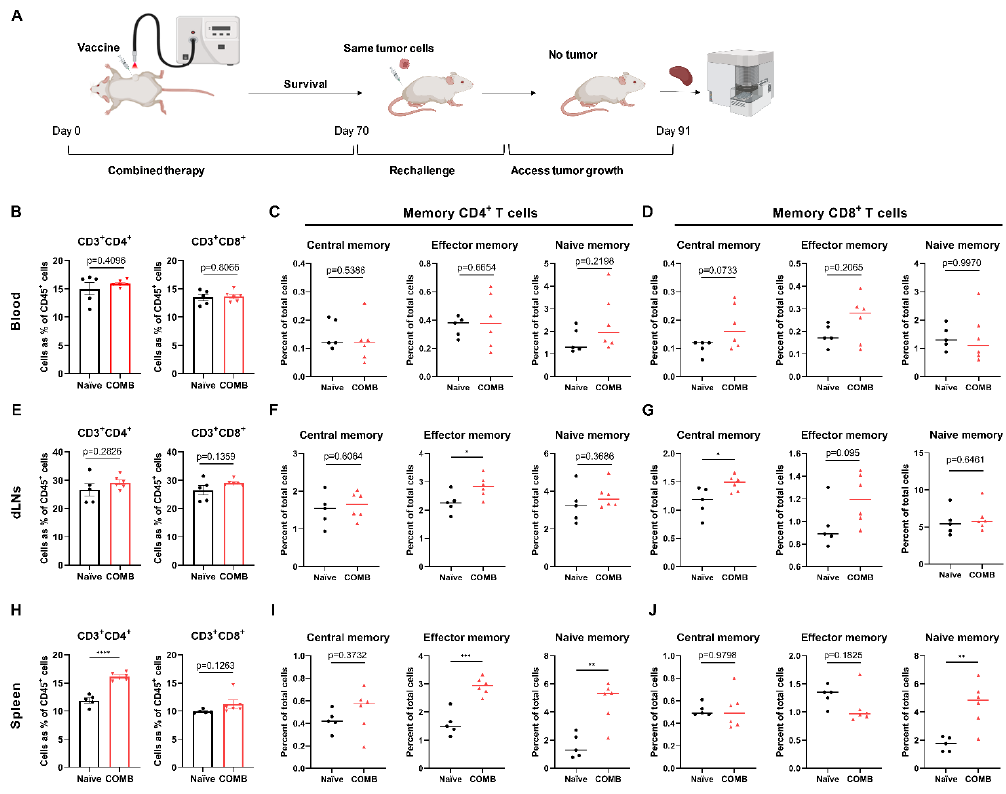
Figure 7. Survival of mice after the treatment of FOSCAN-PDT in combination with HBc VLPs induces immune memory. ( A ) Graphical overview of the experimental design in the MC-38 tumor model. ( B ) The percentage of CD4 + T lymphocytes and CD8 + T lymphocytes in the blood of mice injected with different treatments at 21 days after rechallenge. ( C ) The percentage of CD4 + central memory T cells (CD3 + CD4 + CD44 + CD62L + ), the CD4 + effector memory T cells (CD3 + CD4 + CD44 + CD62L – ), and CD4 + naïve memory T cells (CD3 + CD4 + CD44 – CD62L + ) in the blood of mice with different treatments at 21 days after rechallenge. ( D ) The percentage of central memory CD8 + T cells (CD3 + CD8 + CD44 + CD62L + ), the effector memory CD8 + T cells (CD3 + CD8 + CD44 + CD62L – ), and naïve memory CD8 + T cells (CD3 + CD8 + CD44 – CD62L + ) in the blood of mice with different treatments at 21